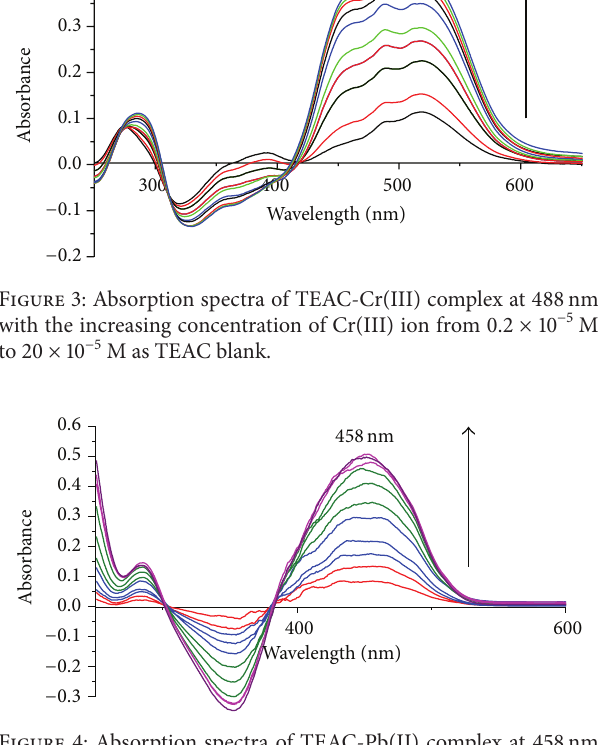
Figure 4: Absorption spectra of TEAC-Pb(II) complex at 458 nm with the increasing concentration of Pb(II) ion from 0.2 × 10 −5 M to 20 × 10 −5 M as TEAC blank.